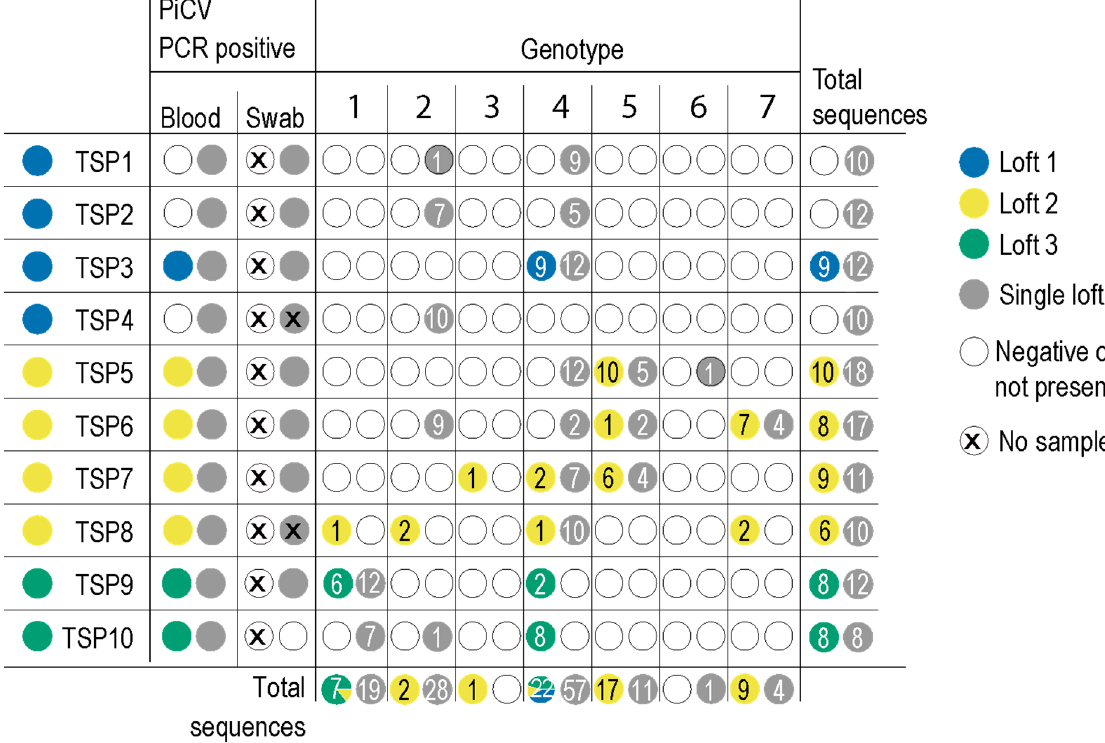
Figure 2. A summary of the PiCV genotypes identified in the study in either the blood or cloacal swab samples. The pigeons were sourced from three separate lofts (loft 1–3) and then house in a single loft. Blood samples were taken when sourced, and thereafter, blood and cloacal swabs were taken at different time points as outlined in Figure 1. Genotypes identified in animals in each of the three lofts and also once they are housed in a single loft are color-coded, and the number in the circles indicates the number of genomes determined that are assigned to the genotype.